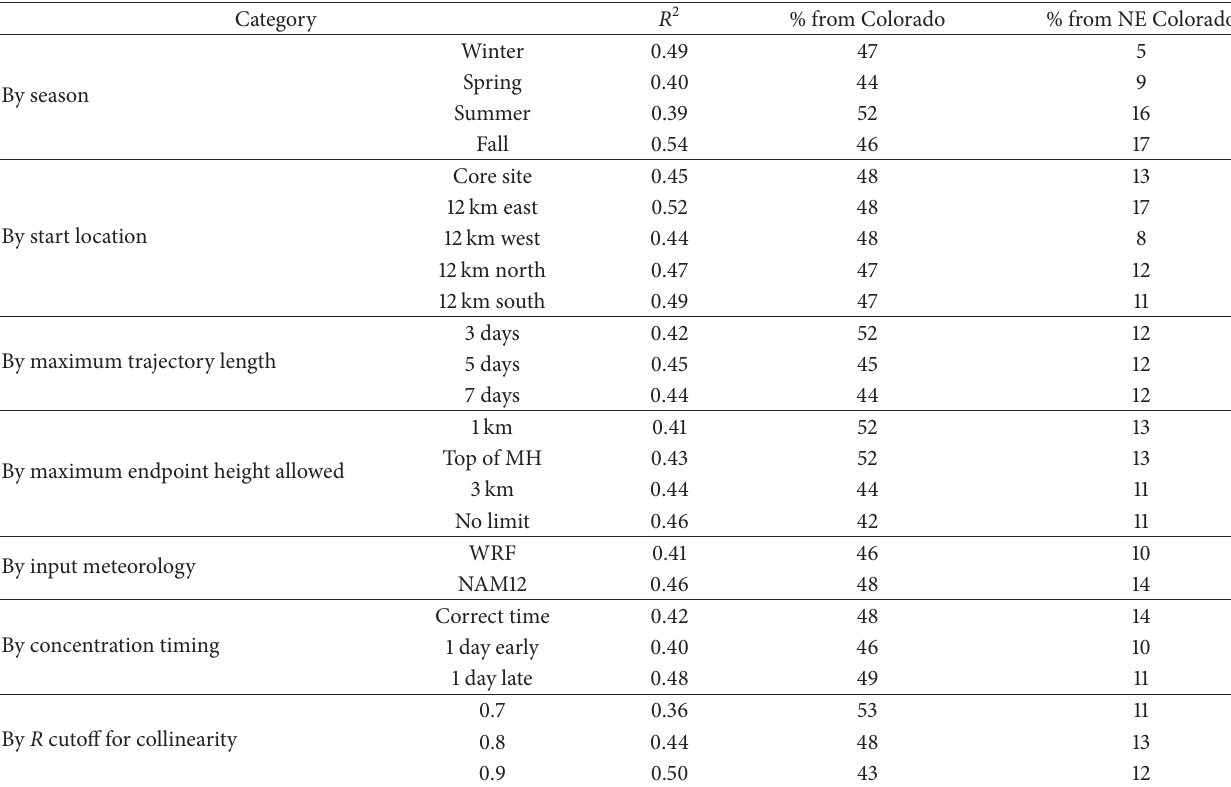
Table 3: Median values of 𝑅 2 , percent of ammonia attributed to Colorado and percent attributed to Northeast Colorado for all TrMB trials. Total number of trials is 4320, so trials/row is 4320 divided by the number of categories. For example there are four seasons, so trials/season is 4320/4 = 1080 .